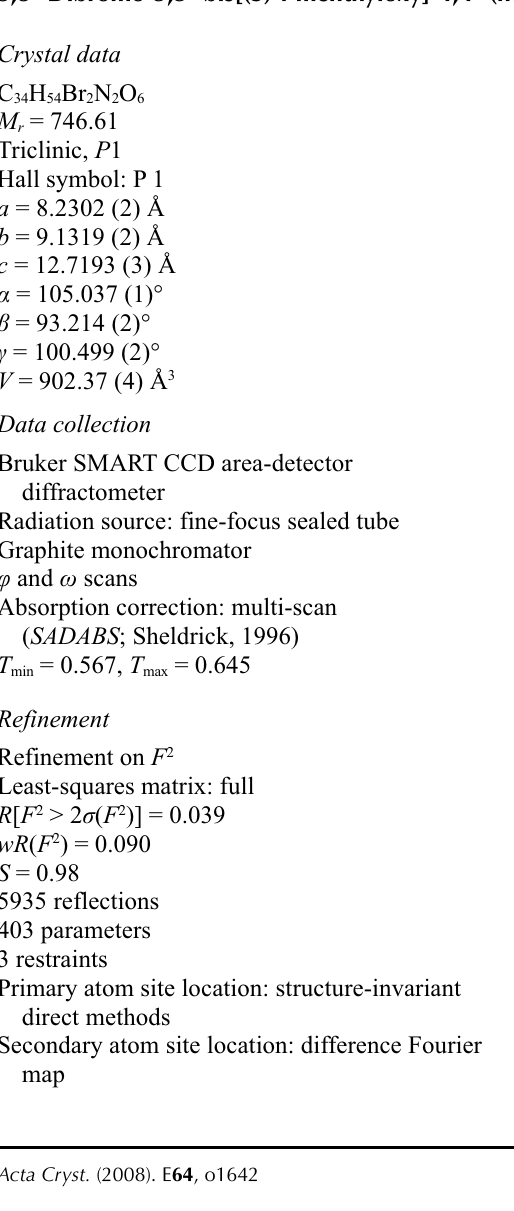
Figure 1 The molecular structure of the title molecule. The atom-numbering scheme is shown at the 50% probability level. 3,3 ′ -Dibromo-5,5 ′ -bis[( S )-l-menthyloxy]-4,4 ′ -(hexane-1,6- diyldiimino)difuran-2(5 H